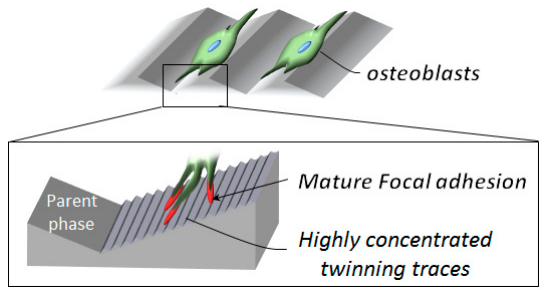
Figure 4. Schematic illustration of cell alignment along slip and/or twinning traces. The mature focal adhesions elongated along the highly concentrated twinning traces, resulting in cellular alignment in the same